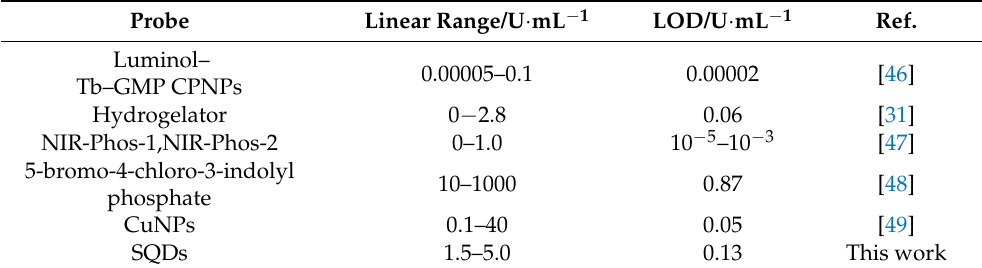
Table 1. Comparison employing fluorescent probes to detect ALP.